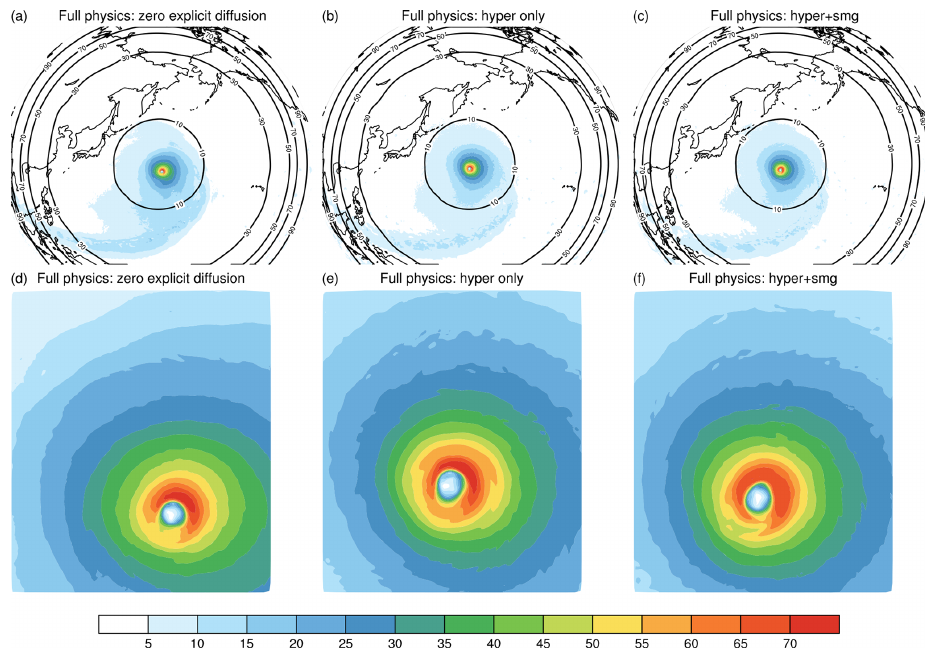
Figure 13. GRIST-NDC full physics tests with the G6B3X16L4 mesh, (a) with no explicit diffusion used, (b) only hyperdiffusion for the horizontal velocity used, and (c) both hyperdiffusion and Smagorinsky diffusion used. Panels (d–f) are the same as (a–c) but zooming in on the major cyclone system. The results are shown for the wind speed (ms − 1 ) at the model level nearest to 850hPa (level 24) on day 10. The contour lines denote the smoothed mesh cell sizes